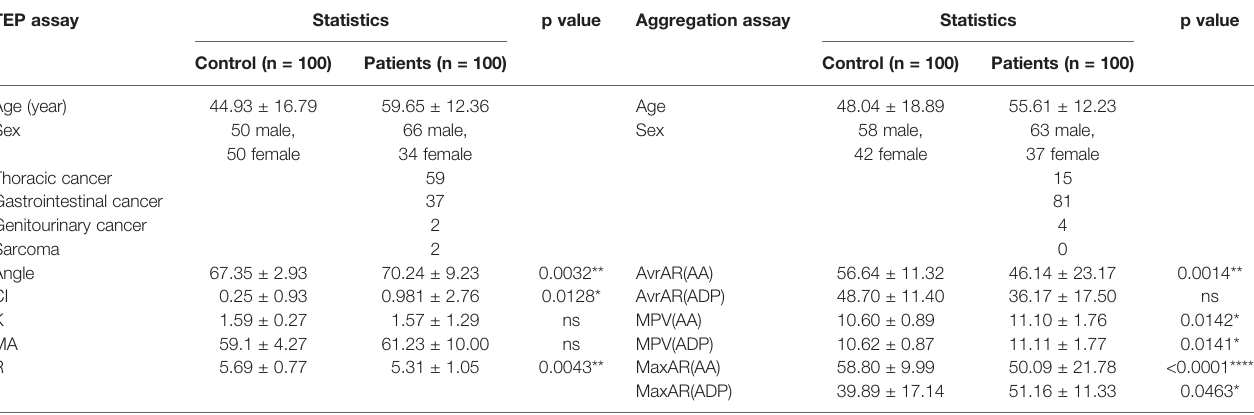
TABLE 1 | Thromboela-stogram (TEG) and platelet aggregation assay. TEP